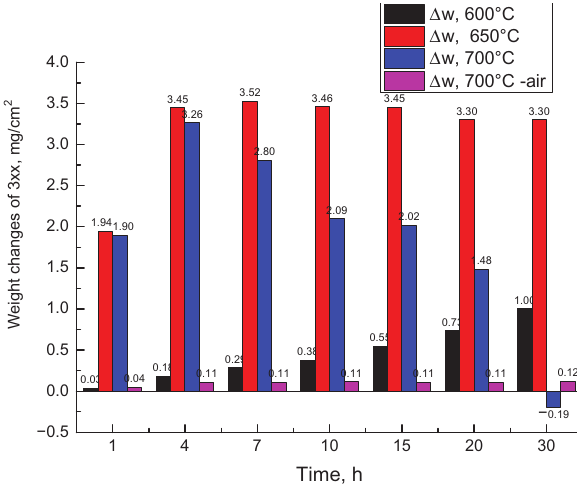
Figure 7: Weight changes during the corrosion process in different temperatures for 3xx material.